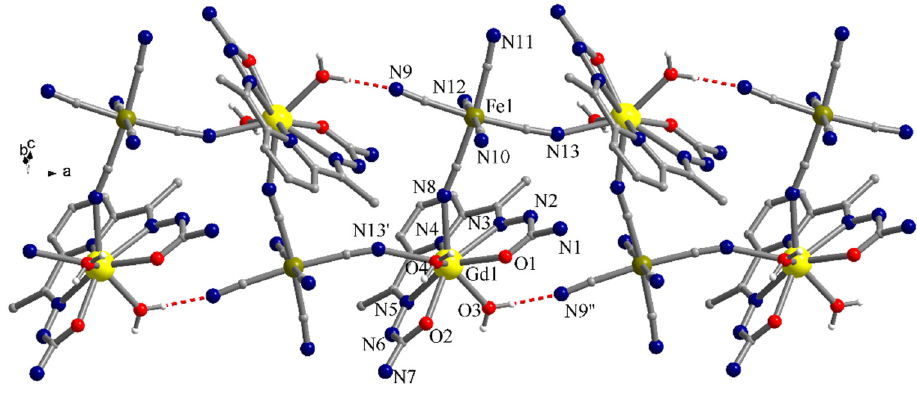
Figure 1. Perspective view of the 1D coordination polymer in compound 1 GdFe (symmetry codes: ’ = − 0.5 + x, 0.5 − y, 1 − z; ” = 0.5 + x, 0.5 − y, 1 − z).